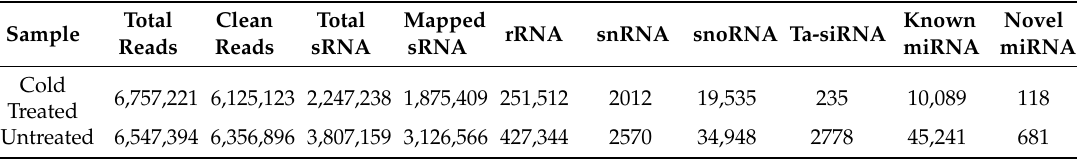
Figure 1. Total sRNA read length distribution of the sequencing libraries (Cold treated, CTD; Untreated, UD). Table 1. Small RNAs obtained in cold-treated (CTD) and untreated (UD) sRNA